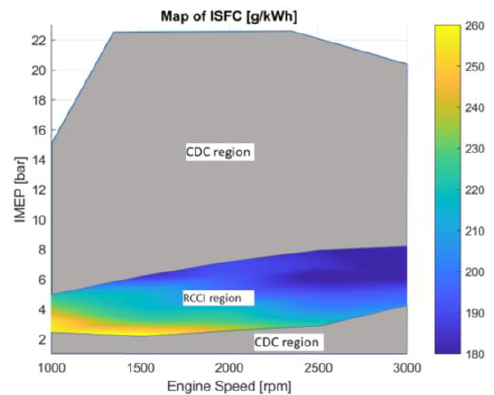
Figure 3. Illustration of the combustion strategies used to cover the engine map with the dual-mode reactivity controlled compression ignition (RCCI) diesel-gasoline/conventional diesel combustion (CDC) concept and indicated specific fuel consumption in the RCCI portion of the map. ISFC: indicated specific fuel consumption.